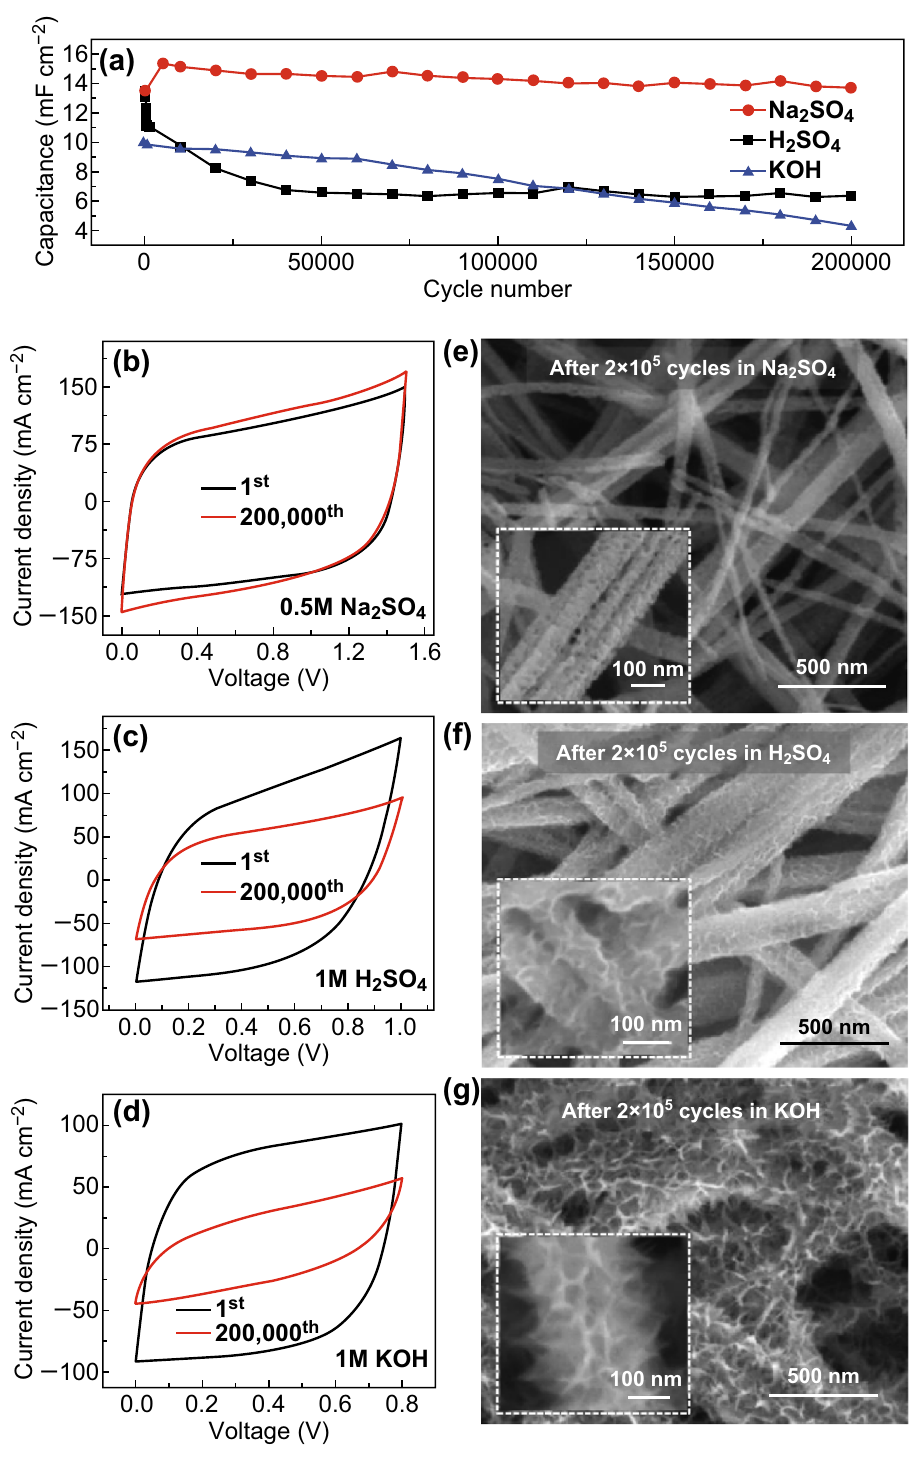
Fig. 6 a Capacitance retention of TiN paper SSC obtained at 1 V s −1 in 0.5 M Na 2 SO 4 , 1 M H 2 SO 4 , and 1 M KOH electrolytes are plotted as a function of cycling number. b – d CV curves of TiN paper SSC collected at the 1st and after the 200,000th cycle in 0.5 M Na 2 SO 4 , 1 M H 2 SO 4 , and 1 M KOH electrolytes at 10 V s −1 . e – g SEM images of the TiN paper electrodes after testing for 200,000 cycles in 0.5 M Na 2 SO 4 , 1 M H 2 SO 4 , and 1 M KOH electrolytes at 1 V s